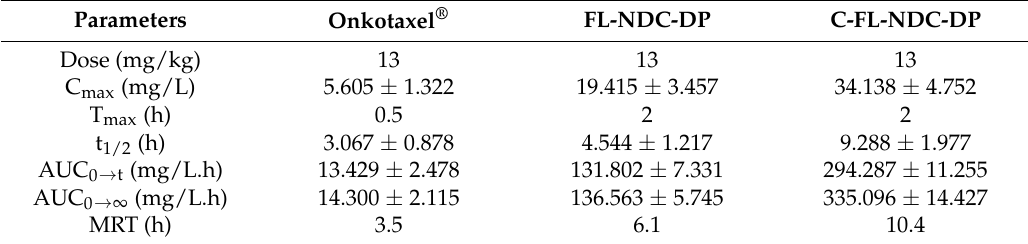
Table 5. Pharmacokinetic parameters following intraperitoneal (IP) administration of the DTX formulations. C max —peak serum concentration; T max —time to reach peak serum